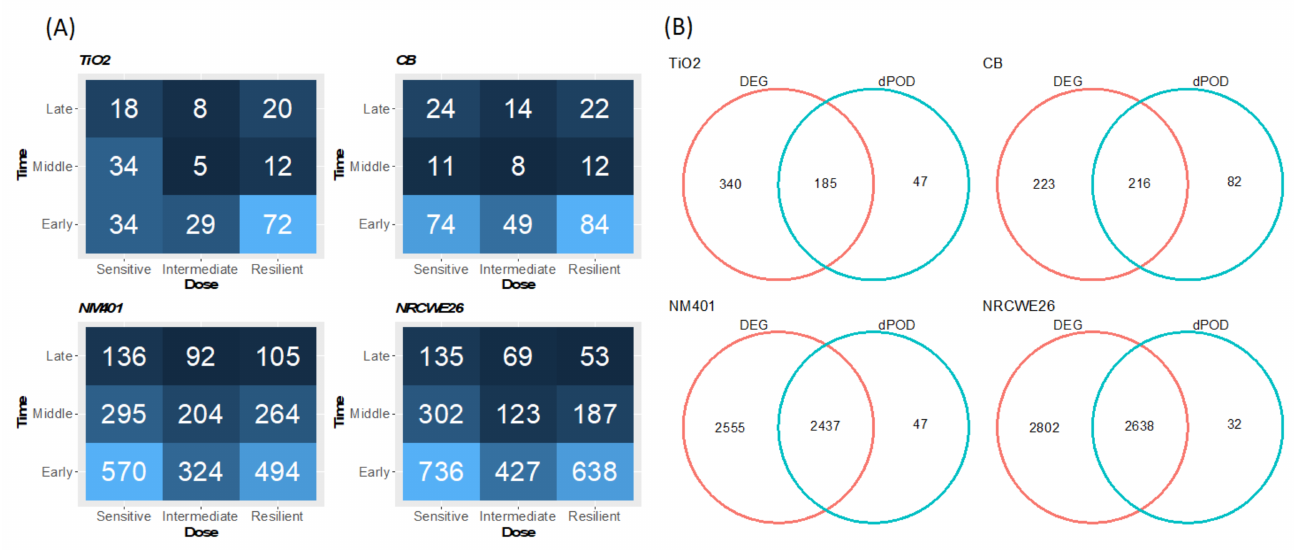
Figure 1. ( A ) Number of dose-dependent genes for each ENM for each of the dose-time labels. The labels can be interpreted as follows: sensitive—genes that respond at low doses; intermediate—genes that respond at intermediate doses; resilient—genes that respond at high doses.; early—genes that respond at short time points; middle—genes that respond at intermediate time points; late—genes that respond at late time points. The blue color gradient describes the number of dose-dependent genes: dark blue represents a smaller number of genes identified, whereas light blue represents a higher number of dose-dependent genes. ( B ) Number of DEG (red) and genes with a dPOD activity label (green) for each